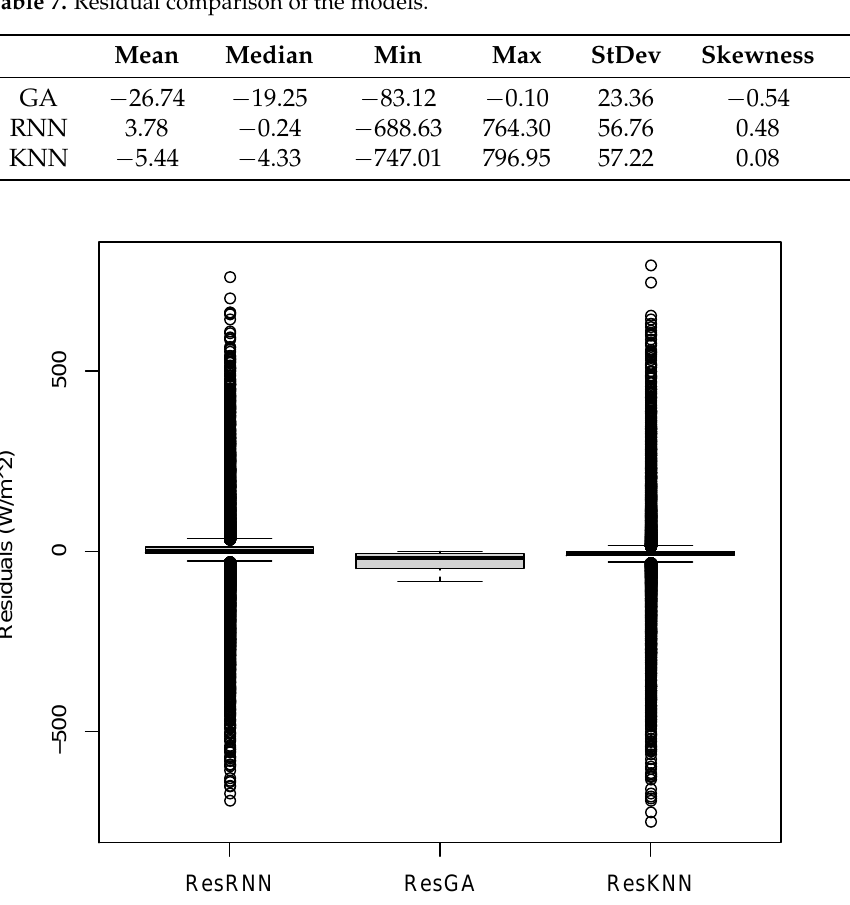
Figure 6. Box plots of the residuals from ResGA, ResRNN, and